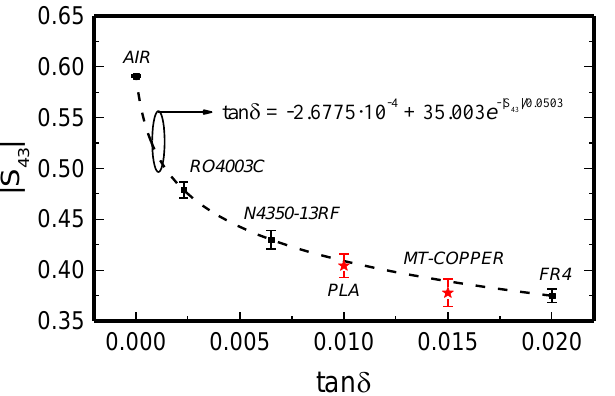
Figure 4. Measured transmission coefficient at f 0 = 6 GHz for different (indicated) MUT samples. The mean values, as well as the error bars, obtained from N = 3 independent measurements are depicted. Reprinted with permission from [37].